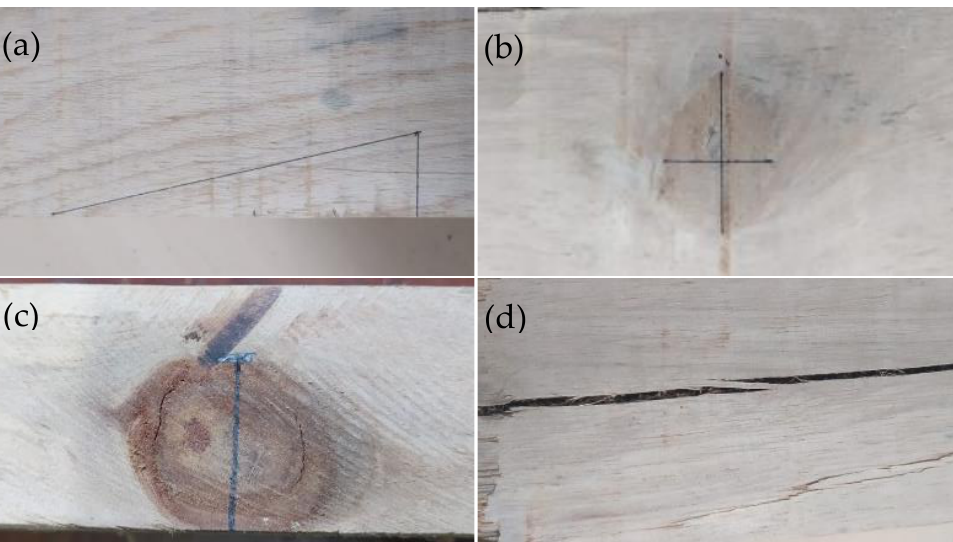
Figure 2. Measurement of defects and imperfections to calculate the strength ratio value ( S ) of bending following ASTM D245 [64]: ( a ) the slope of the grain was measured by the tangent of the angle between the direction of the fibers and the edge of the specimen; ( b ) knots at the wide face were measured by the average of their largest and smallest diameter; ( c ) knots at the narrow face were measured by their width between the lines enclosing the knot and parallel to the edges of the specimen; and ( d ) shakes, checks, and splits were measured at the ends of the specimen. The length ( L ) of each specimen was measured employing a tape measure, while width ( b ) and depth ( d ) were measured using a digital caliper with an accuracy of 0.01 mm. The mass was measured three times: before the bending test ( m 0 ), after the bending test ( m 1 ), and after oven-drying ( m ot ). The specimens used for measuring m 1 and m ot were 4 × 4 × 4 cm 3 and were cut near the bending test specimen’s failure position. The M c value was calculated according to Equation (9). The density ( ρ ) was calculated in air-dry conditions before the bending test of a full-size specimen (Equation (13)), while the relative density or specific gravity ( G b ) was calculated according to Equation (14).